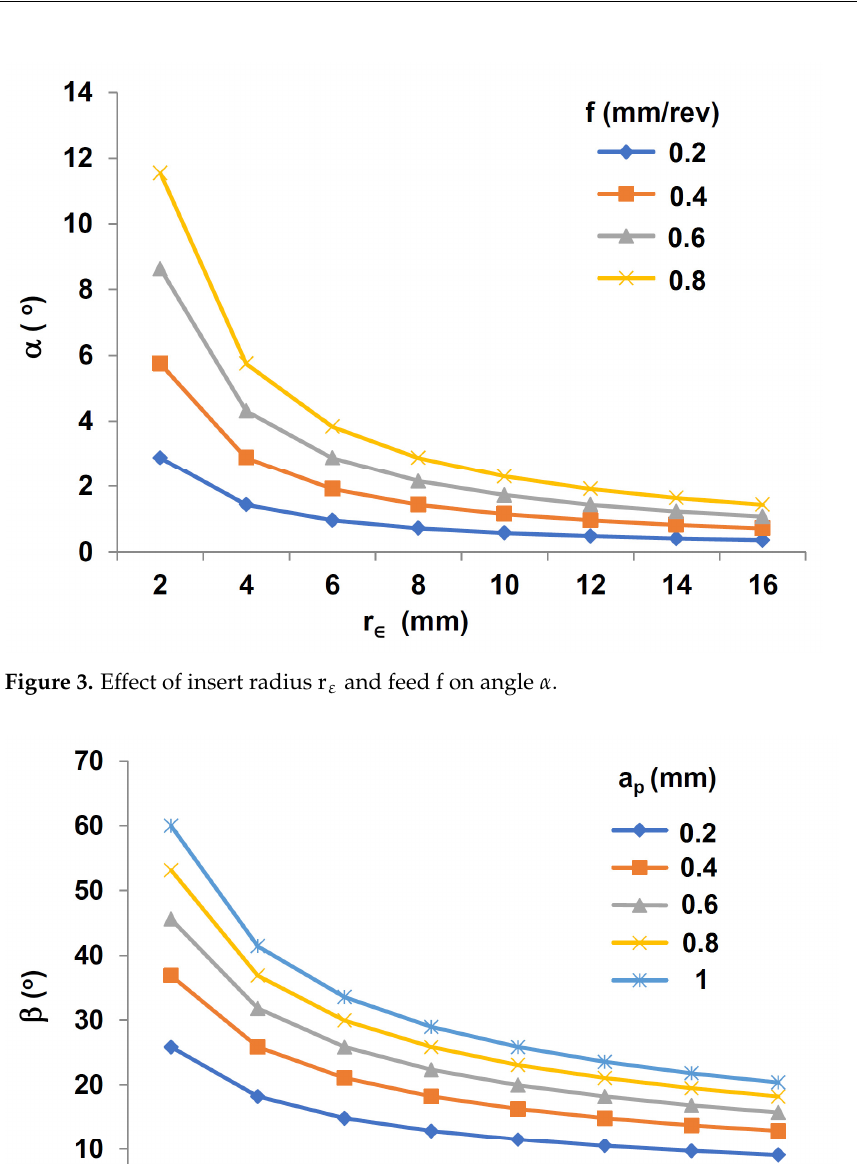
Figure 2. Round inserts produced by Sandvik Coromant [33]: ( a ) T-Max ® P system RCMX type (IC = 10, 12, 16, 20, 26, 32 mm); ( b ) CoroTurn ® 107 system RCMT type (IC = 05, 06, 08, 10, 12, 16, 20, 25, 32 mm).